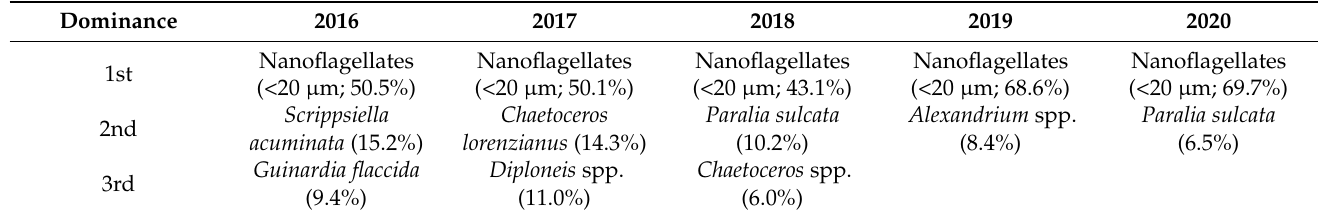
Figure 6. Vertical distribution of the average DIN ( a ), PO 4 ( b ), and SiO 2 ( c ) concentrations (in µM) in the northern East China Sea from 2016 to 2020. Table 2. Dominant phytoplankton taxa in the northern East China Sea from 2016 to